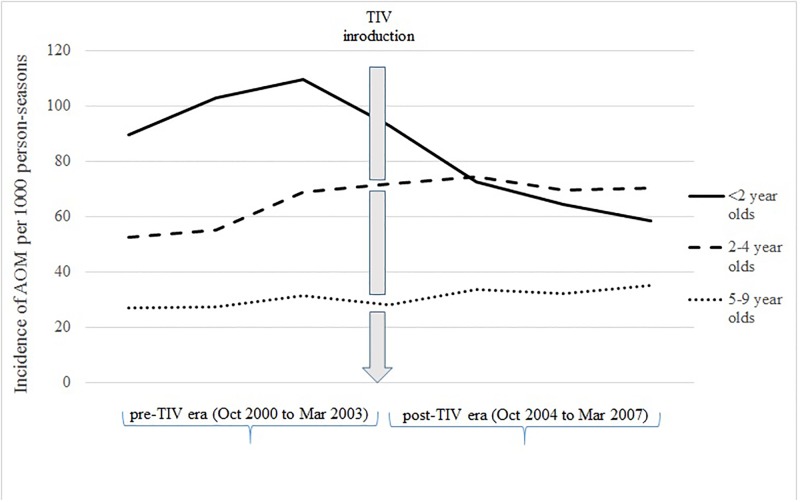
Significant reduction in AOM incidence was observed after introduction of the trivalent influenza vaccine (TIV).In children < 2 years old, who received free influenza vaccination, there was a significant reduction in AOM incidence after the introduction of the TIV in 2004. Meanwhile, the seasonal incidence of AOM in those 2–4 years old and 5–9 years old in 2004–2006 were significantly increased.